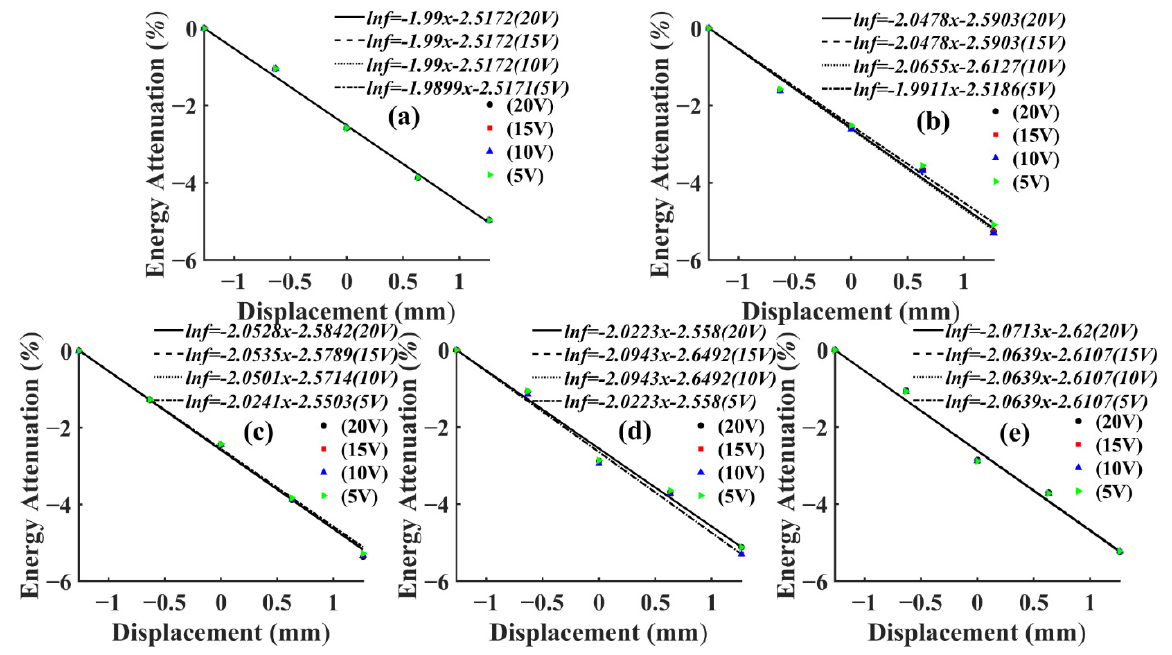
Figure 8. Fitting curve of AE signal energy attenuation of T1 specimen. ( a ) Pulse frequency 1 kHz; ( b ) Pulse frequency 10 kHz; ( c ) Pulse frequency 30 kHz; ( d ) Pulse frequency 50 kHz; ( e ) Pulse frequency 150 kHz.